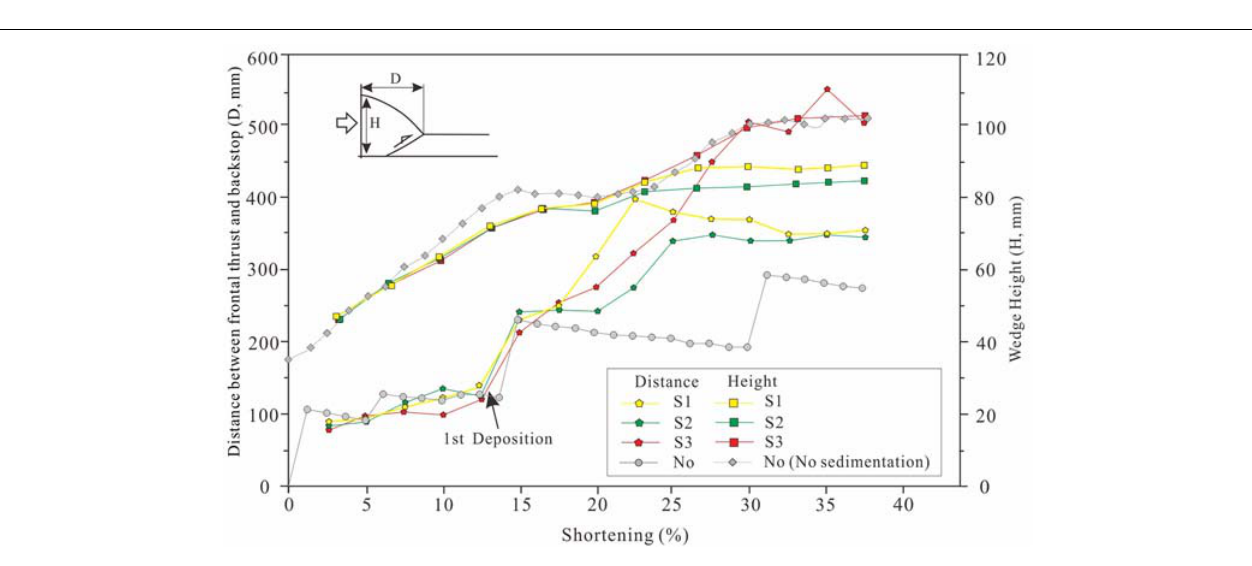
topography in the southern segment of the Longmenshan is related to the localization of detachment within lower to middle Triassic evaporite sequence in the Longmenshan foreland